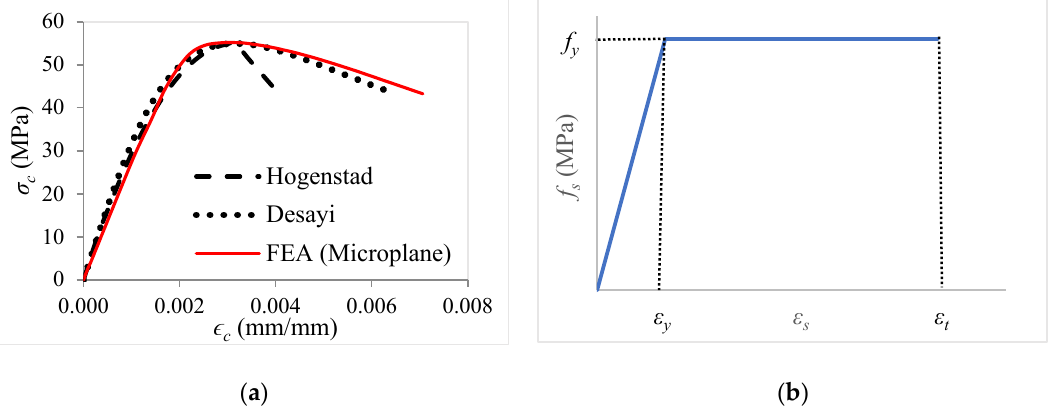
Figure 4. Stress versus strain curves: ( a ) concrete; ( b ) steel reinforcements.